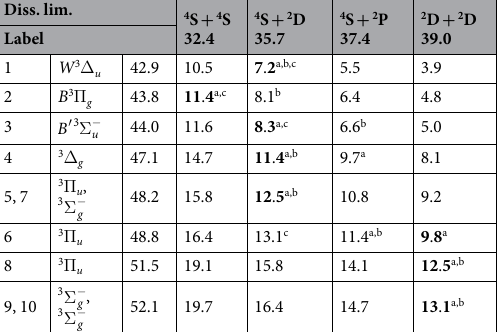
Table 3. The estimation of the KER from the double ionization potentials and the dissociation limits of the Auger final states. The first and second columns show the indexes and the assignments adopted from Bao et al . 30 , while the binding energies are adopted from Arion et al . 19 . Then the energies of the dissociation limits are calculated from the energy levels from NIST 44 . The numbers in bold font represent the assigned states. The energies are in eV. a Observed now. b Predicted by Bao et al . 30 . c Observed by Lundqvist et al . 32